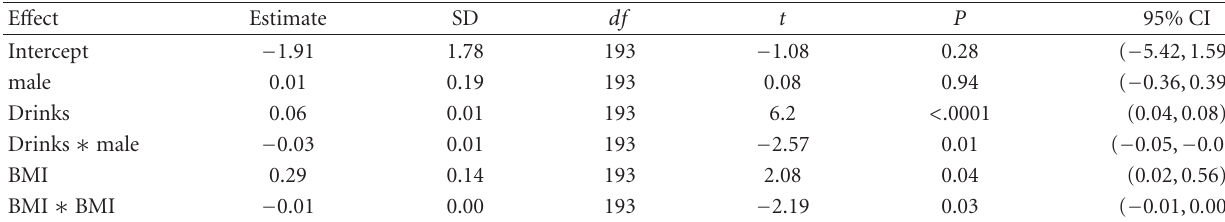
Table 3: Association of RAPI with BMI adjusted for number of drinks and